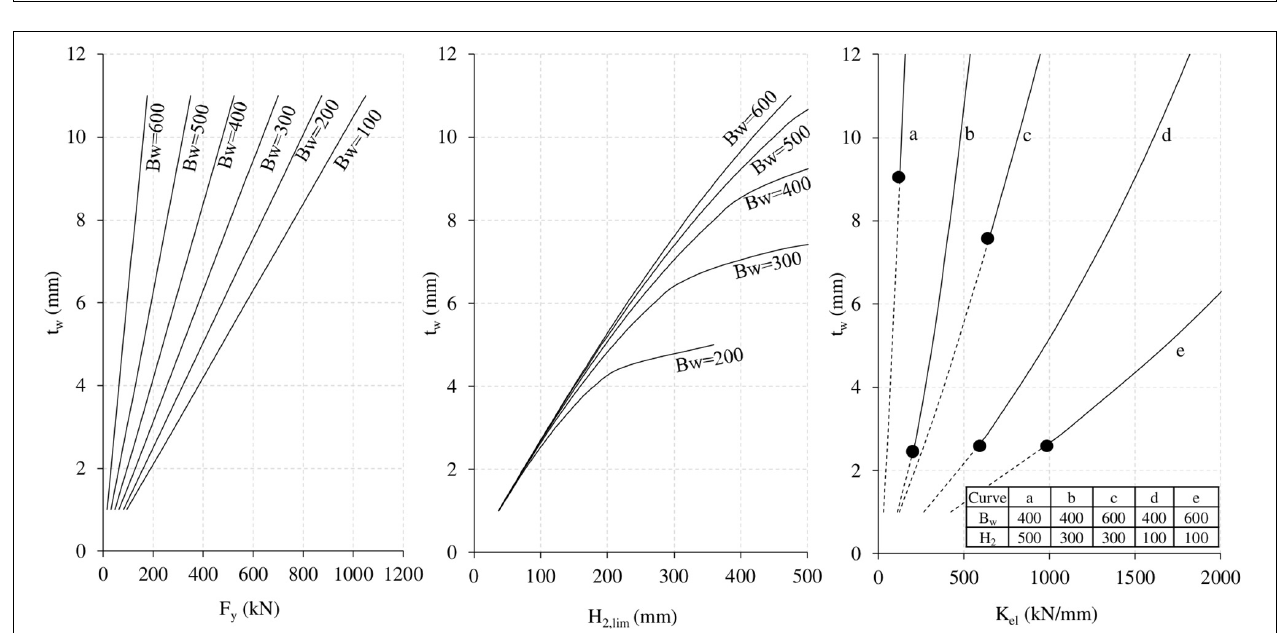
FIGURE 8 | Preliminary design chart of SL devices (S275 steel grade; B w and H 2 expressed in mm).